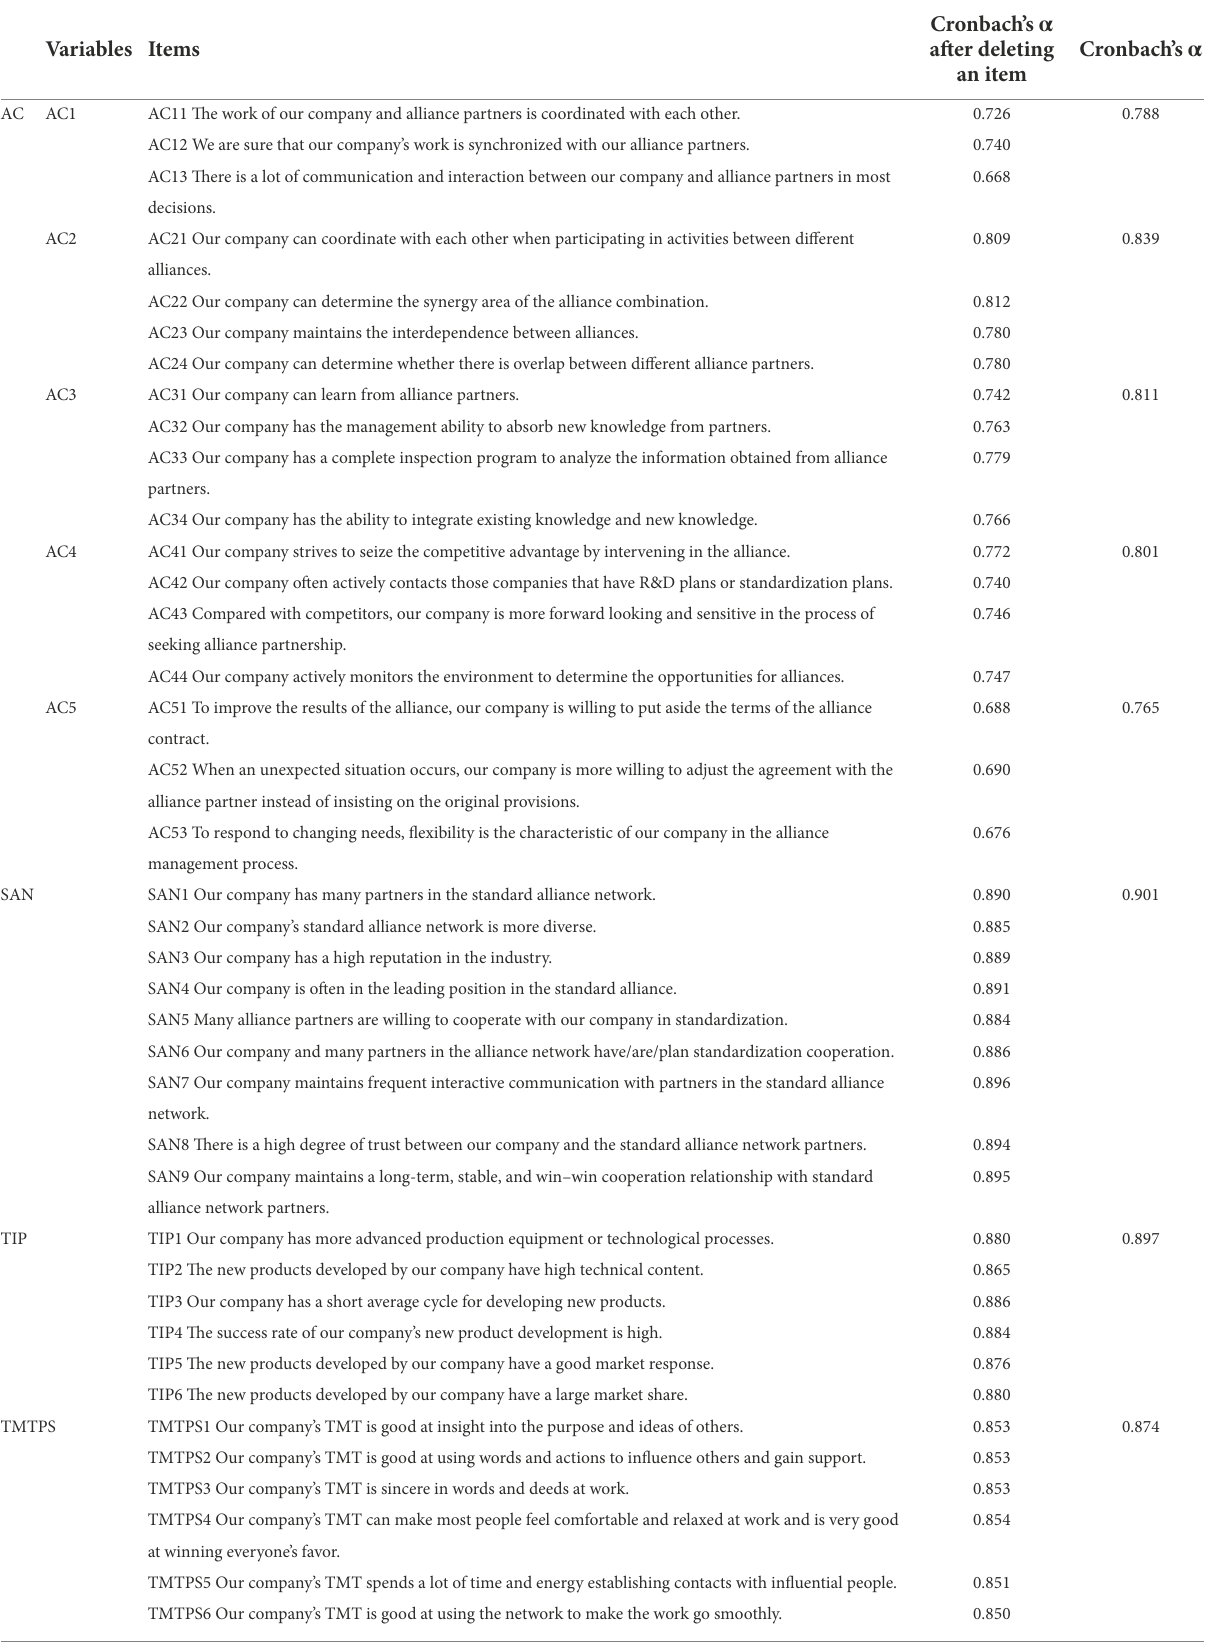
TABLE 2 Reliability analysis of